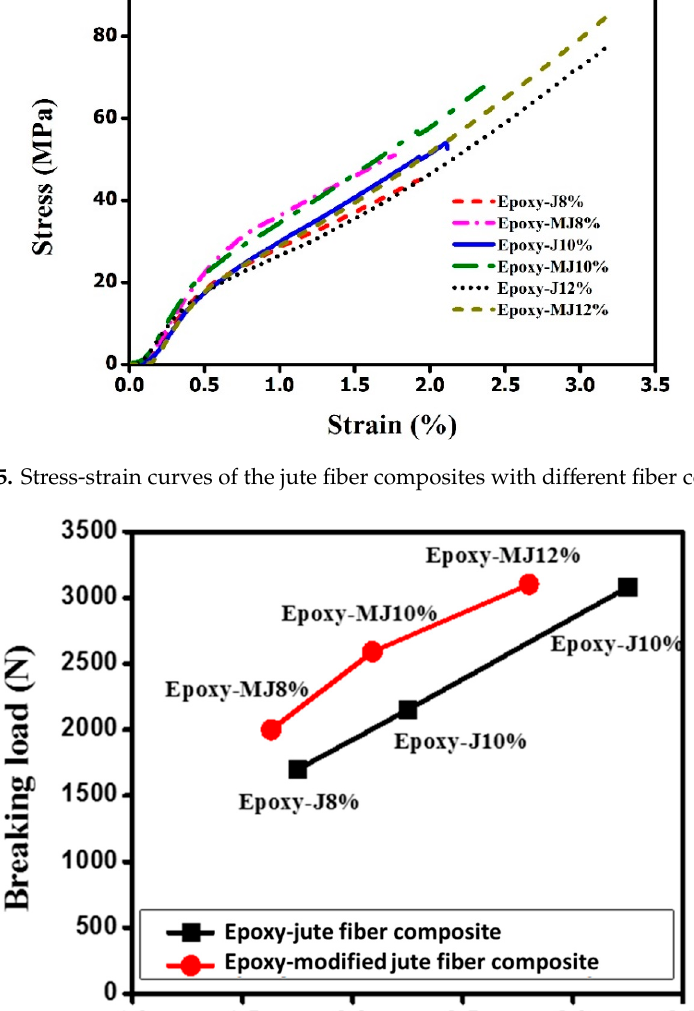
Figure 4. Effect of fiber loading on the tensile strengths of the modified composites.